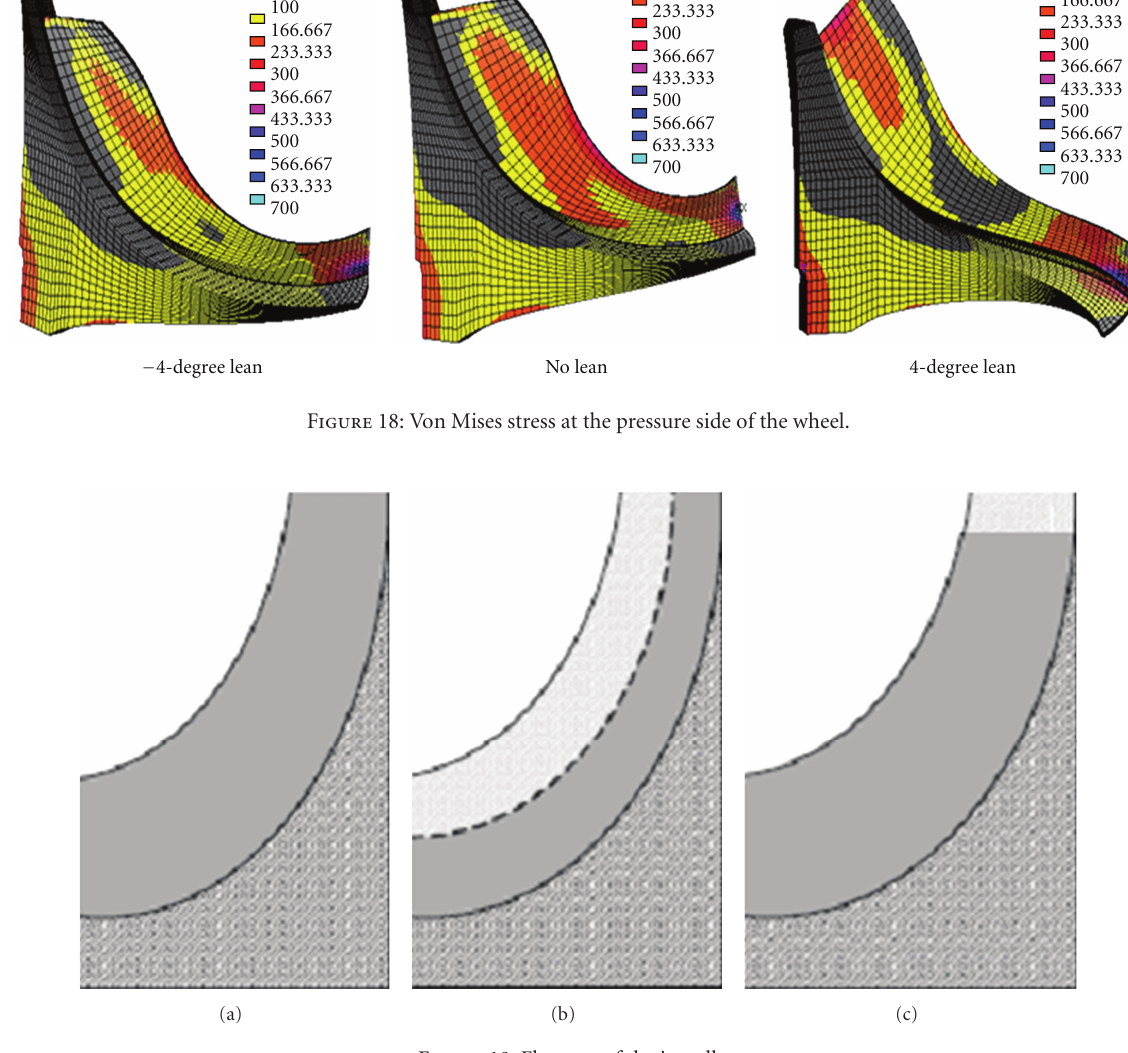
Figure 19: Flow cut of the